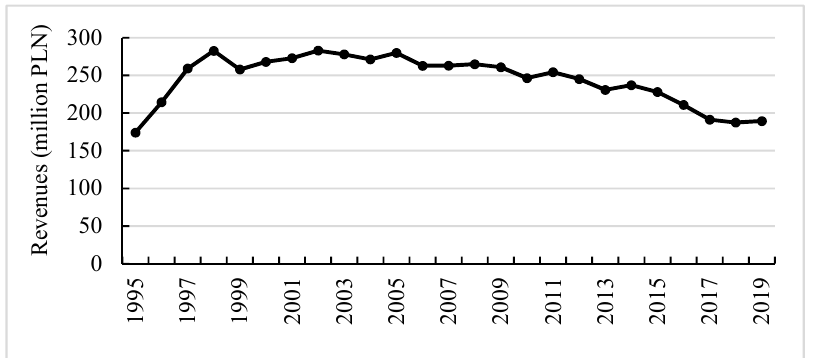
Figure 6. Total annual revenues from market fee on permanent and seasonal marketplaces in Poland in 1995–2019. Source: own elaboration based on data from the Local Data Bank.